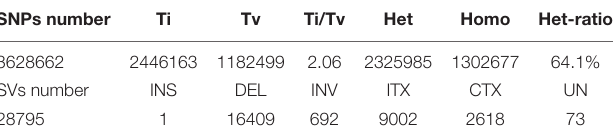
TABLE 2 | The classification of nucleotide substitutions in the SNPs detected and summary of SVs identified in Munake cultivar aligned with the reference